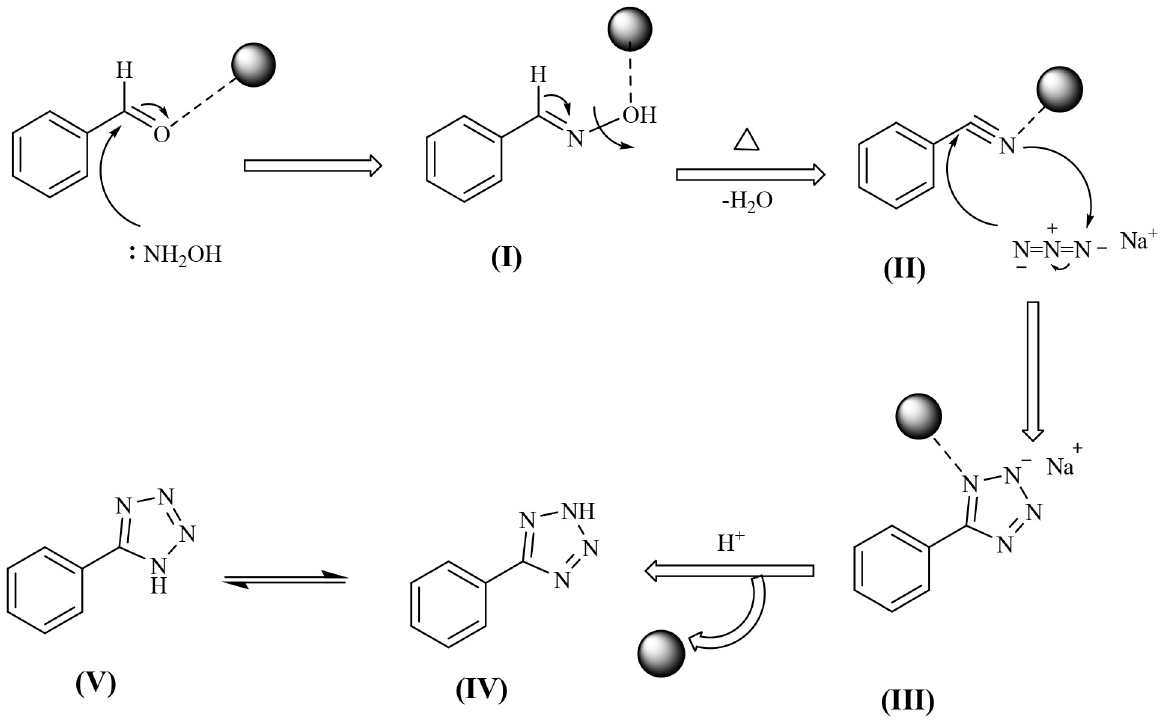
The plausible mechanism for the synthesis of 5-sub- stituted 1 H -tetrazoles from aldehydes was shown in Scheme 3 using Cu/C as catalyst. First, oxime is formed on the aldehyde according to the activation of the carbonyl group of the aldehyde and the nucleophilic attack of